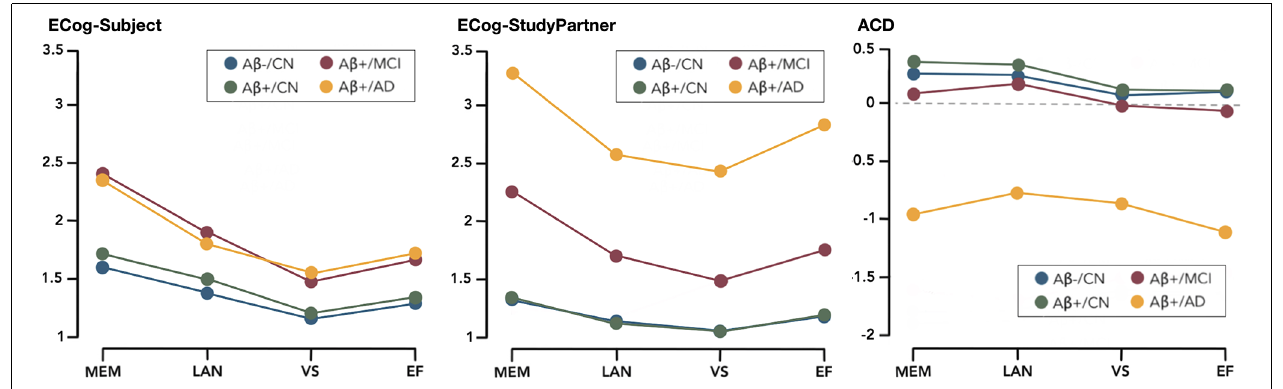
FIGURE 1 | ECog-Subject, ECog-StudyPartner, and ACD by domain between groups.